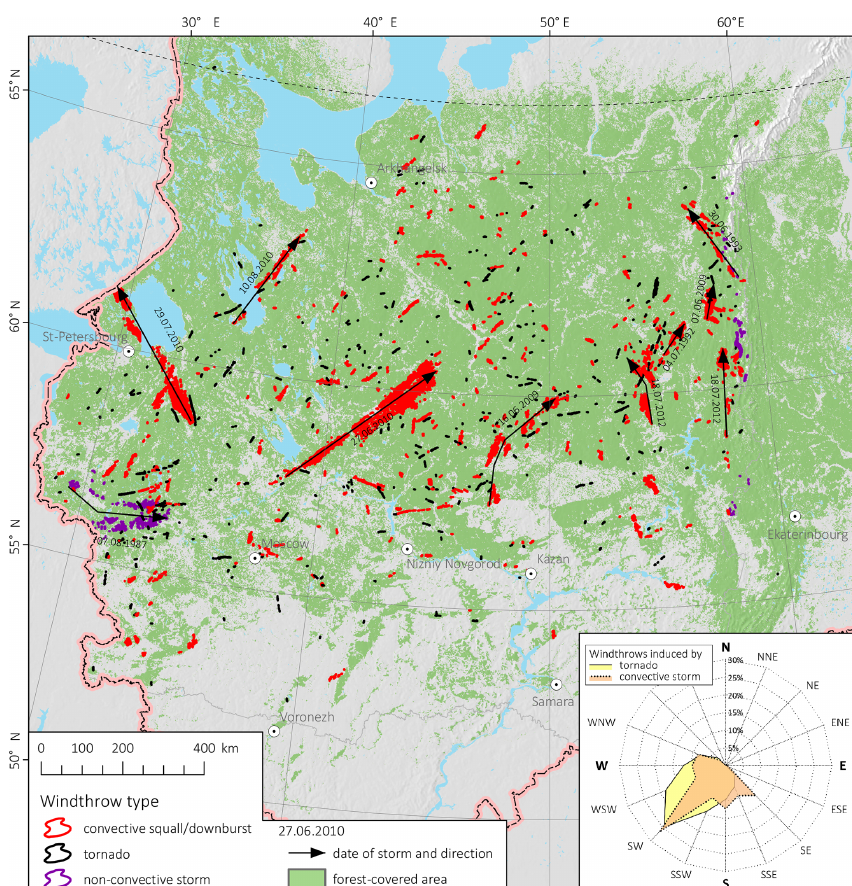
Figure 10. Spatial distribution of stand-replacing windthrows in ER in 1986–2017. The 10 most catastrophic windthrows with the largest damaged area are shown by arrows and indicated by the corresponding dates of the windthrow. Forest-covered area is estimated according to the data from Bartalev et al. (2016). The inset shows the direction from which the windthrow